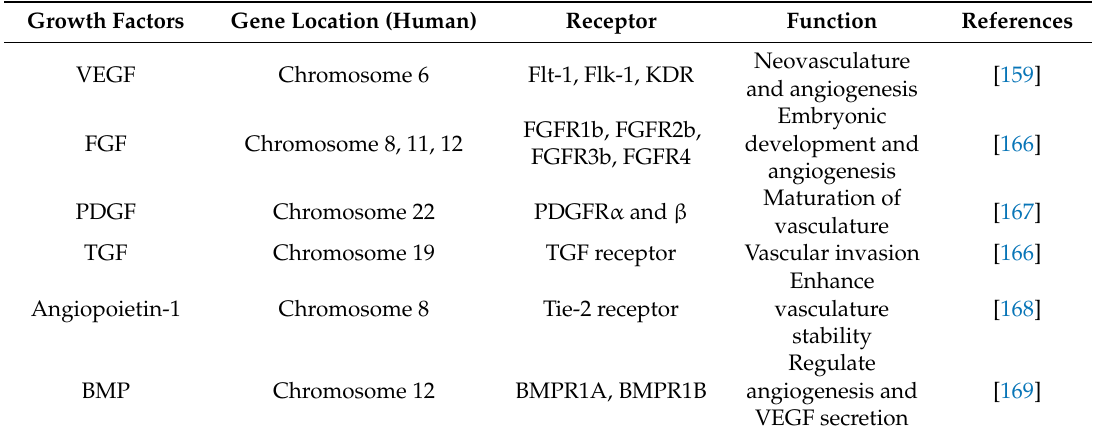
Table 3. Growth factors used to stimulate